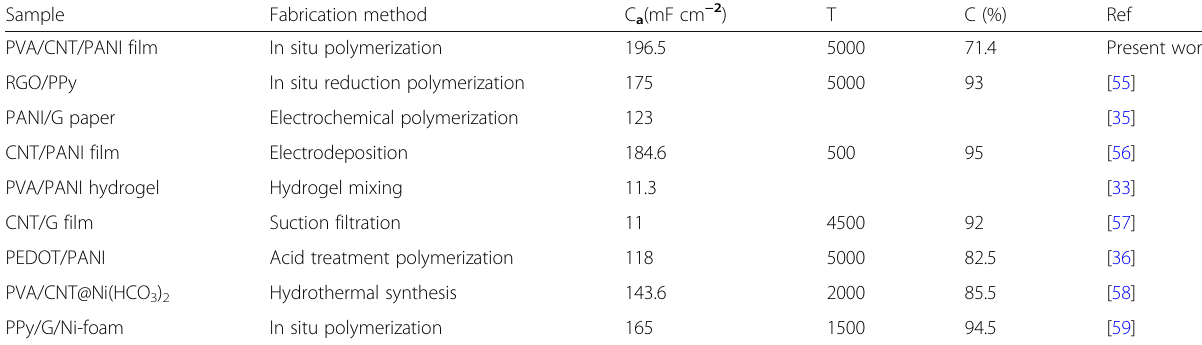
Table 1 Summary of the capacitive performance of the supercapacitors based on similar materials